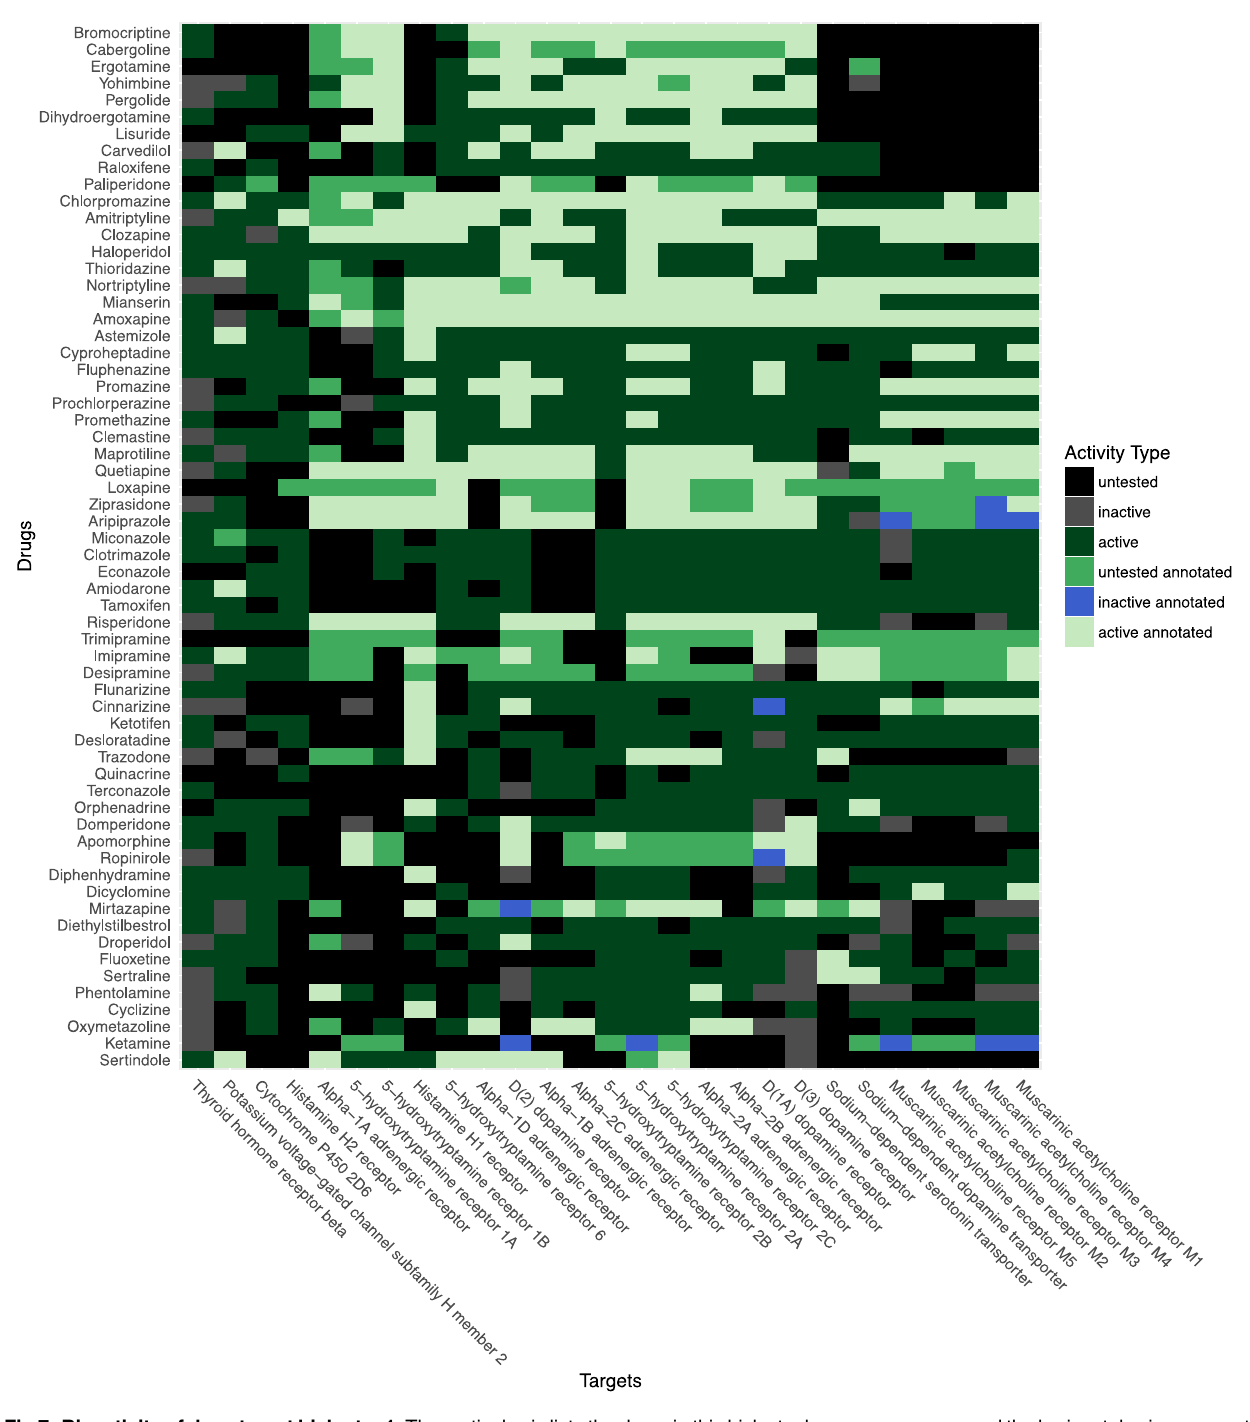
Fig 7. Bioactivity of drug-target bicluster 1. The vertical axis lists the drugs in this biclusterby common name, and the horizontalaxis represents the UniProt names for the representative targets of each sequence-similar target cluster. The compound-target pairs are colored accordingto one of six colors: untested in PubChemBioAssay (black), inactive in PubChemBioAssay (grey), active in PubChemBioAssay (dark green), untested but annotated as active in DrugBank(green), inactive in PubChemBioAssay but annotatedas active in DrugBank (blue), and active and also annotated as active in DrugBank(light green). Rows and columns are sorted by bioactivity profile similarity.